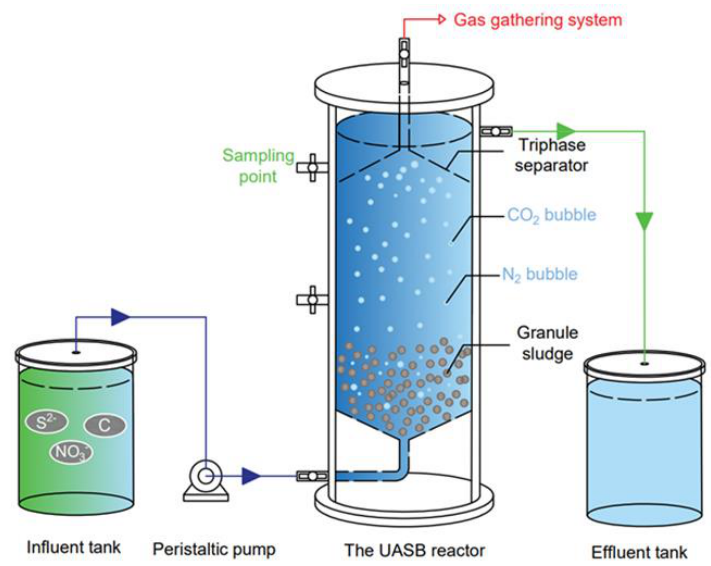
Figure 1. Schematic diagram of heterotrophic-autotrophic denitrification reactor. Table 1. Influent conditions of the UASB reactor during different